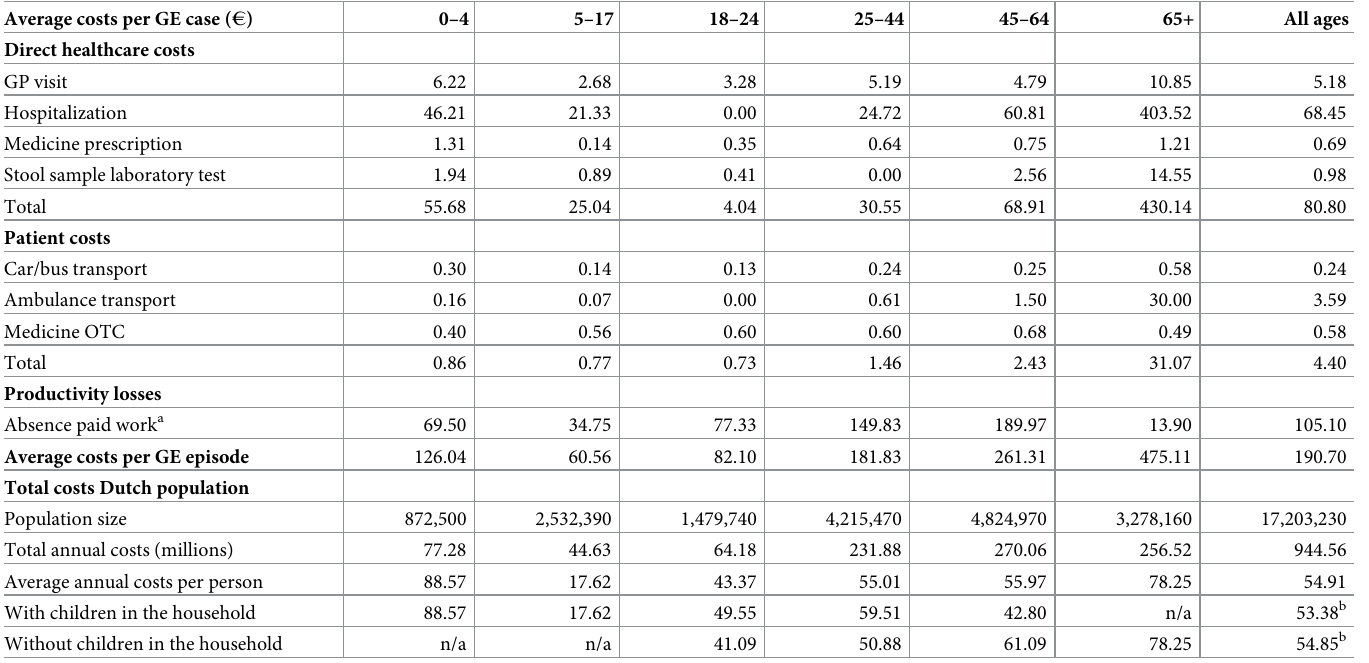
Table 5. Average costs of gastroenteritis by resource unit and age group, and estimated total costs for the Netherlands. Average costs per GE case ( €